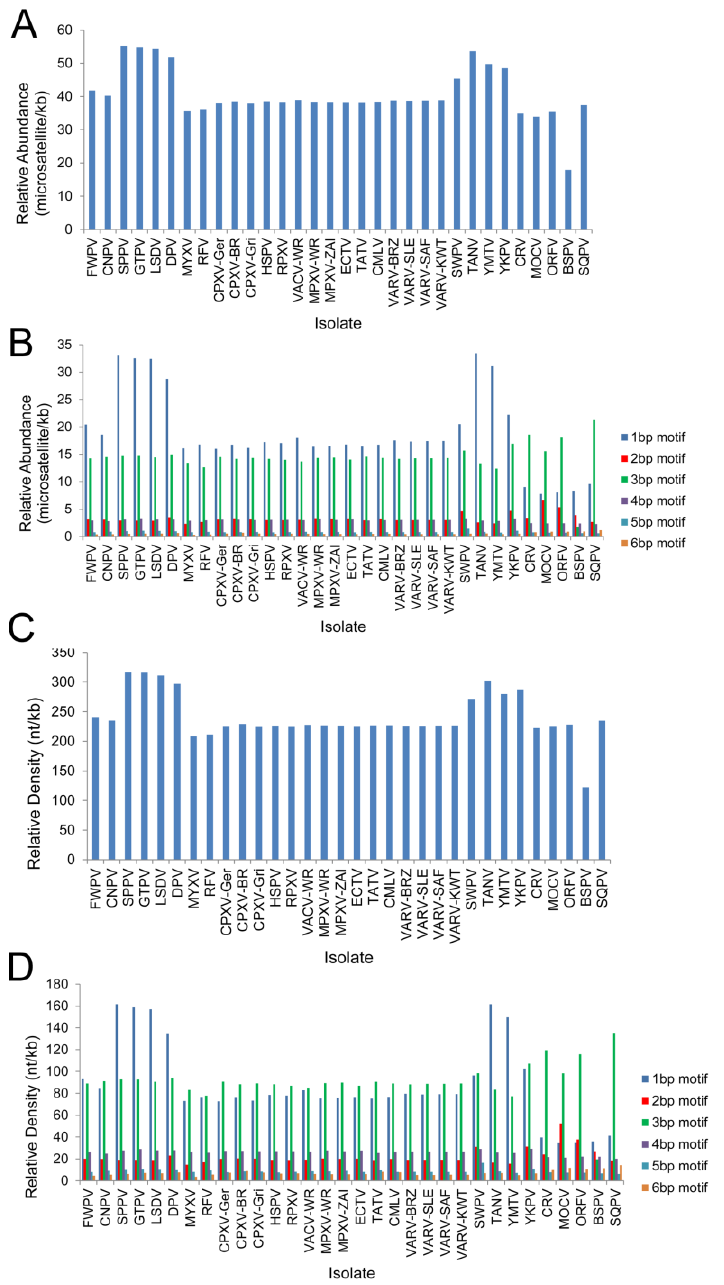
Figure 4. Relative abundance and density of microsatellites. RA for ( a ) all microsatellites and for ( b ) each motif length measured (1 bp to 6 bp) for each isolate. RD for ( c ) all microsatellites and for ( d ) each motif length measured for each isolate. The high GC viruses are shown at the right end of each